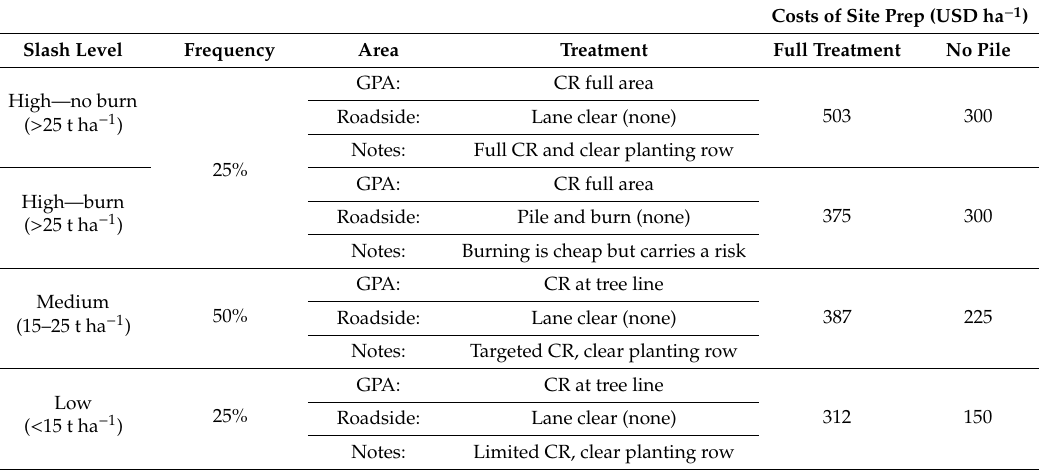
Table 4. Site preparations procedures and costs for whole-tree harvesting systems with and without pile